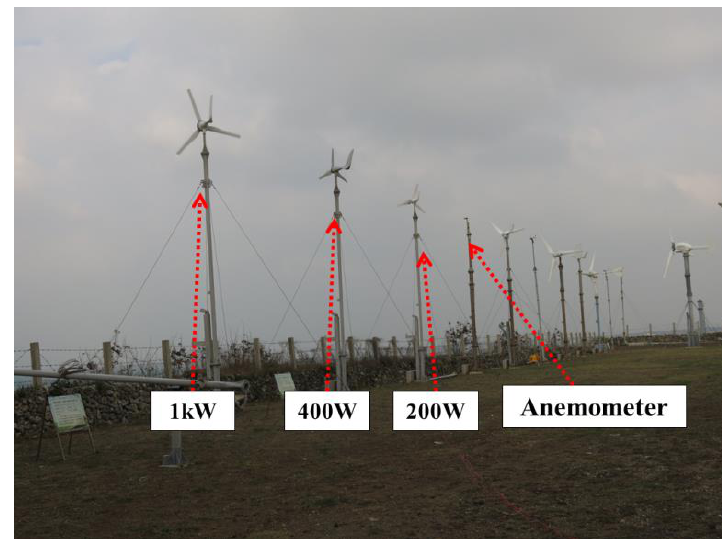
Figure 1. Small-scale HAWT systems tested at Penghu .